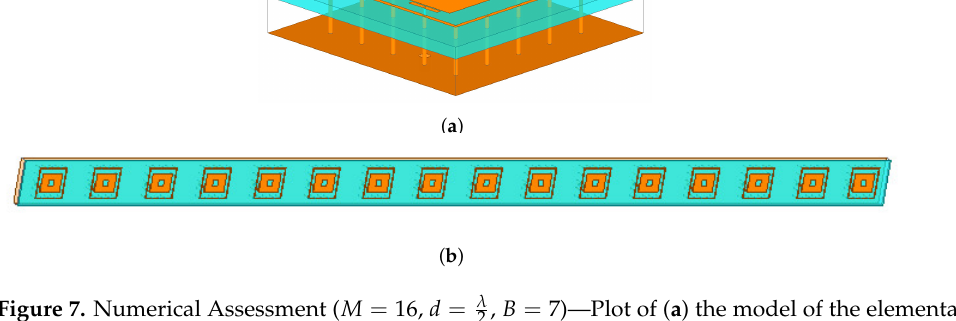
Figure 7. Numerical Assessment ( M = 16, d = λ radiator and of ( b ) 16-element sparse linear plank.